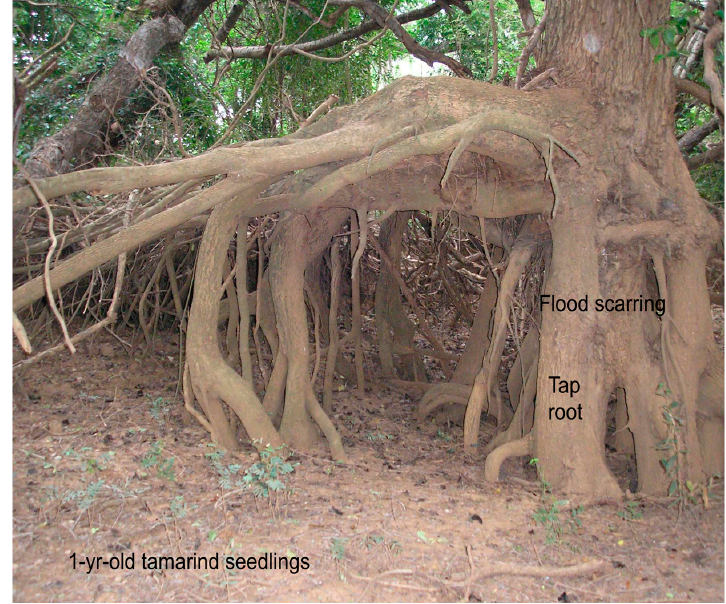
Figure 3. Bank-side tamarind roots exposed by floods at Ankoba. Flood dates and rates of erosion can be estimated from anatomical changes in roots damaged by catastrophic flooding.